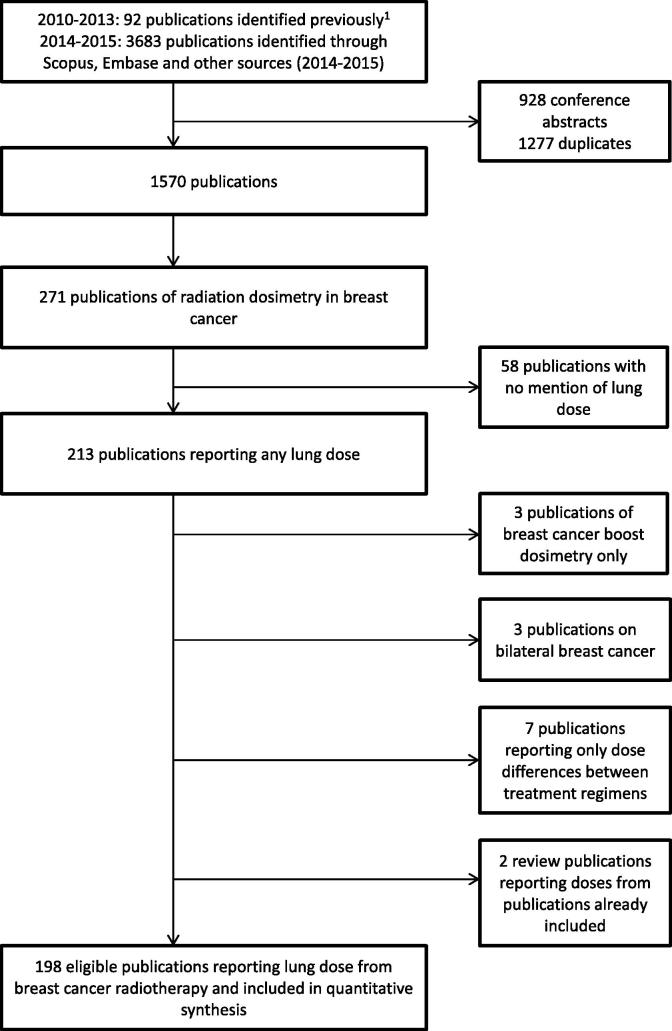
The process of study identification for the review.